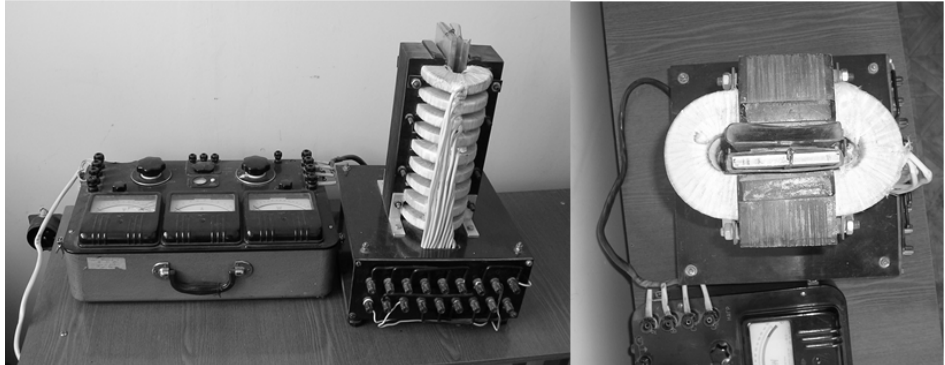
Figure 4. The LIM experimental unit. Table 2. Parameters of the LIM experimental unit.